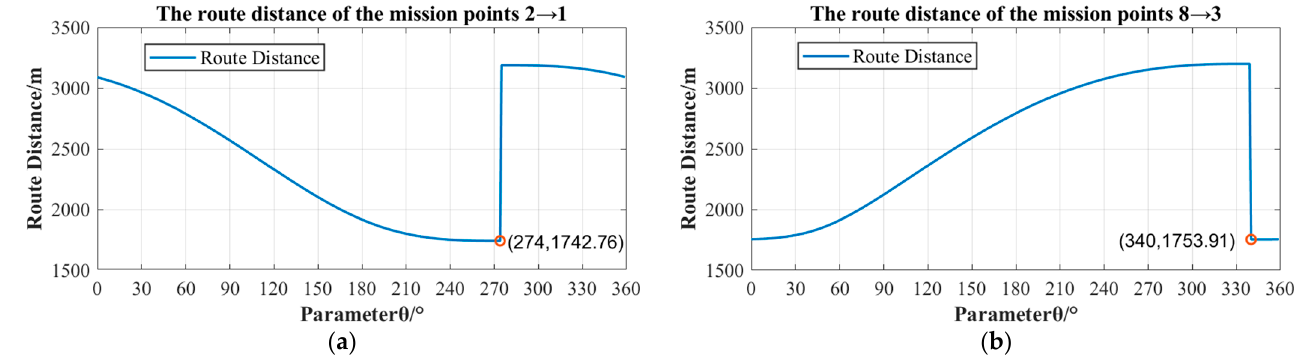
Figure 11. Schematic diagram of the route distance of two adjacent mission points corresponding to different parameters θ . ( a ) the relationship between parameter θ and the route distance of the mission points 2 → 1, ( b ) the relationship between parameter θ and the route distance of the mission points 8 →